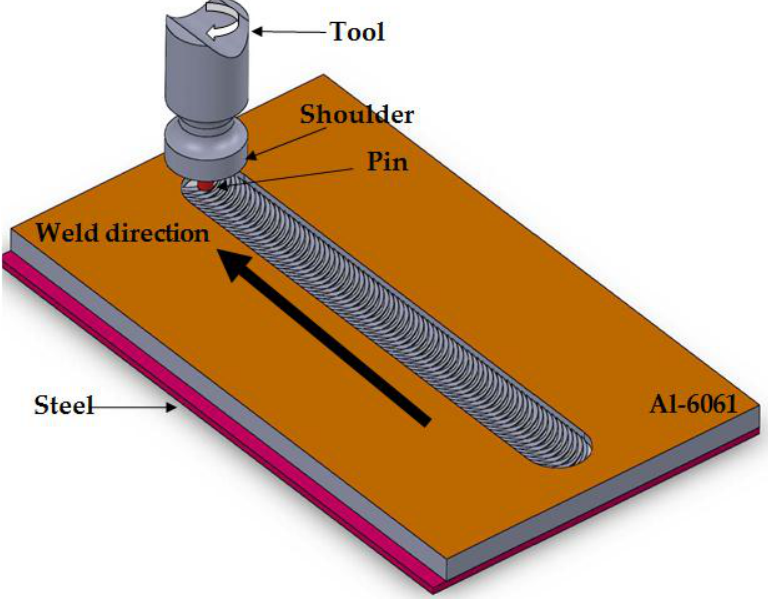
Figure 1. Friction stir welding (FSW) process with a lap joint configuration.